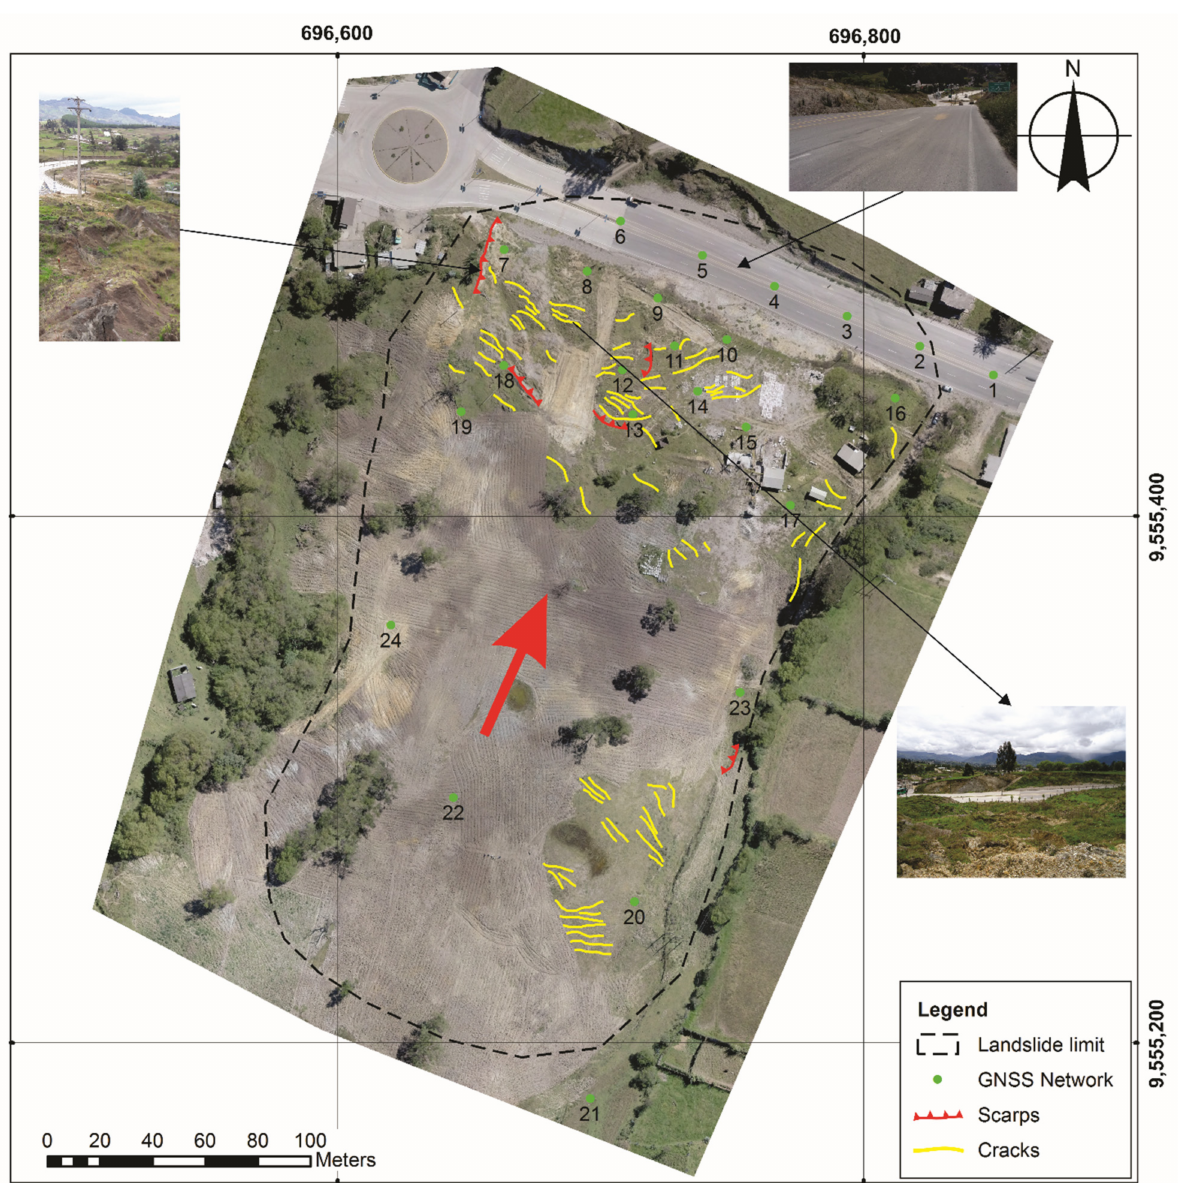
Figure 3. Geomorphological evidence in the Colinas Lojanas study area (July 2016) showing cracks distributed within the landslide body and the main scarps. The photograph of the road clearly shows the deformation produced at the foot of the landslide and affected